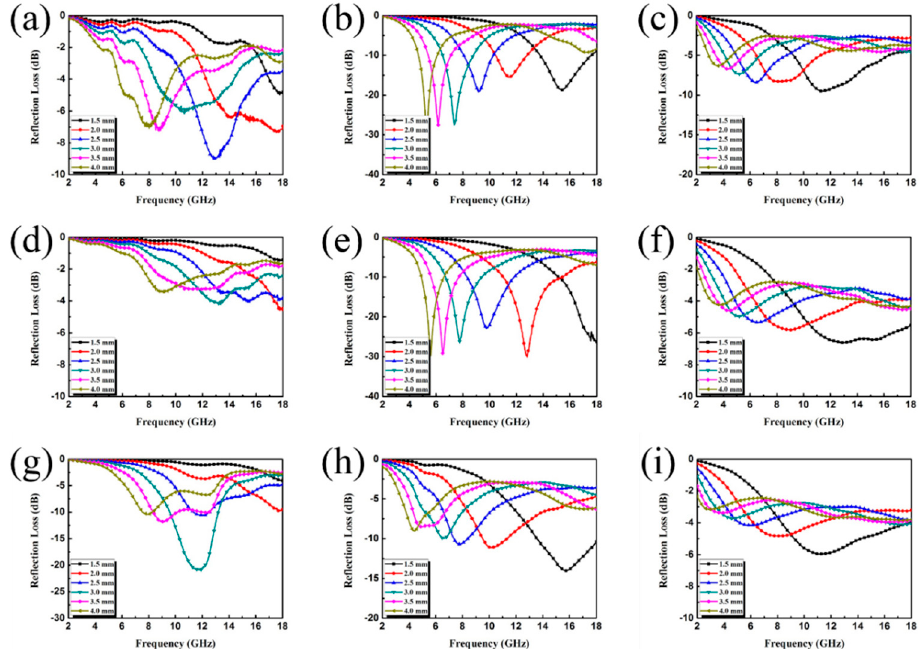
Figure 9. Reflection loss curves of the filler loadings of ( a,b,c ) sample A; ( d,e,f ) sample B; ( g,h,i ) sample C, with 20 wt.%, 30 wt.%, and 40 wt.% in wax composites with thicknesses from 1.5 to 4.0 mm in the frequency range of 2–18 GHz.